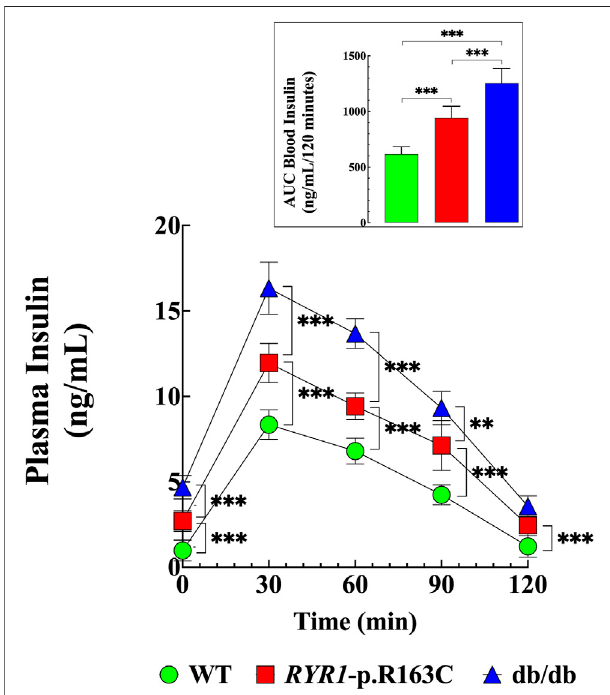
FIGURE 3 | Abnormal insulin levels in response to glucose challenge. Insulin levels were determined in WT, RYR1- p.R163C, and db/db mice after a glucose load. The basal level of insulin was higher in RyR1 -p.R163C and db/db than in WT mice and during the test duration of 120 min. The insert shows the AUC calculated using the trapezoid rule of the insulin determination (GraphPad Prism software 9.0). Values are expressed as mean ± S.D. Experiments were conducted in n mice = 6 per genotype. Statistical analysis was performed as described above. ** = p < 0.01, *** = p <